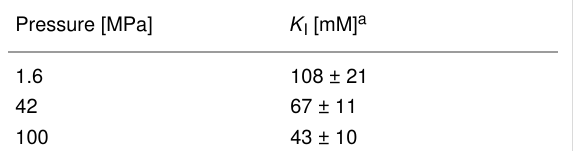
Table 4: Determined inhibition constant for pyruvate for the immobi- lized epimerase.